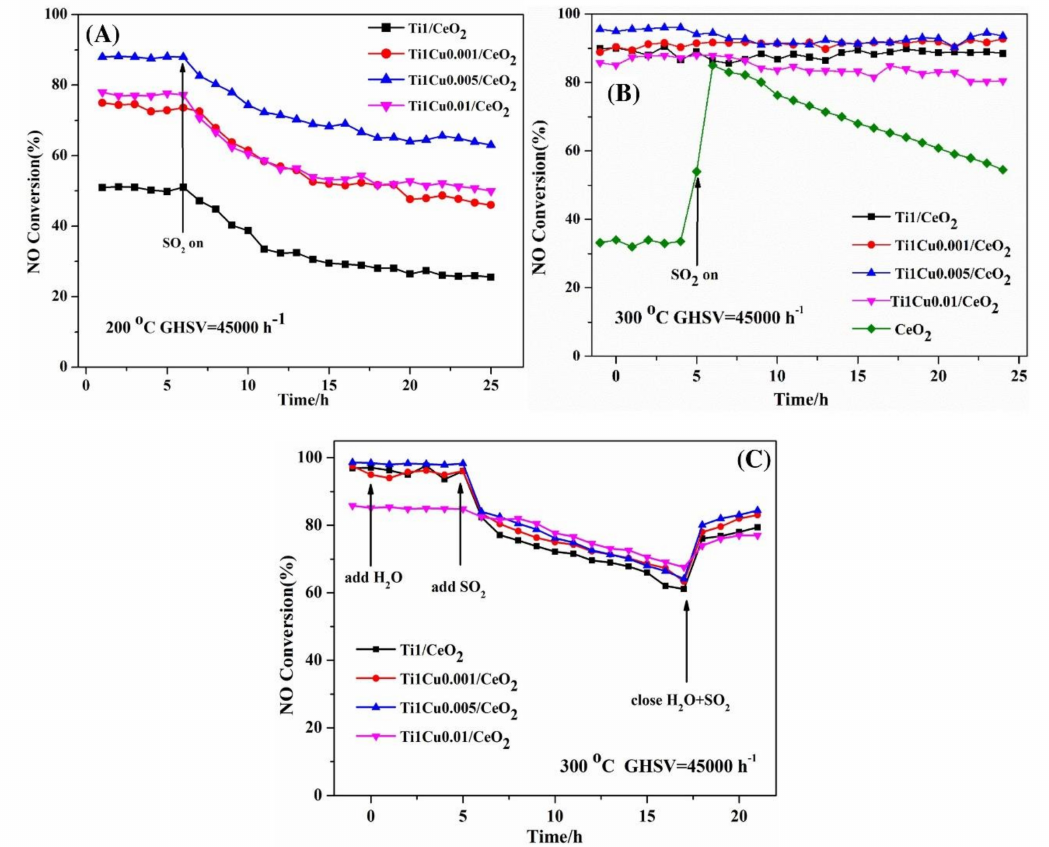
Figure 8. The H 2 O and SO 2 durability of catalysts ( A ) SO 2 durability over Ti1 / CeO 2 and Ti1Cuy / CeO 2 catalysts at 200 ◦ C ( B ) SO 2 durability over Ti1 / CeO 2 and Ti1Cuy / CeO 2 catalysts at 300 ◦ C. ( C ) H 2 O / H 2 O ◦ C + SO / CeO / CeO 2 durability over Ti1 2 and Ti1Cuy 2 at 300